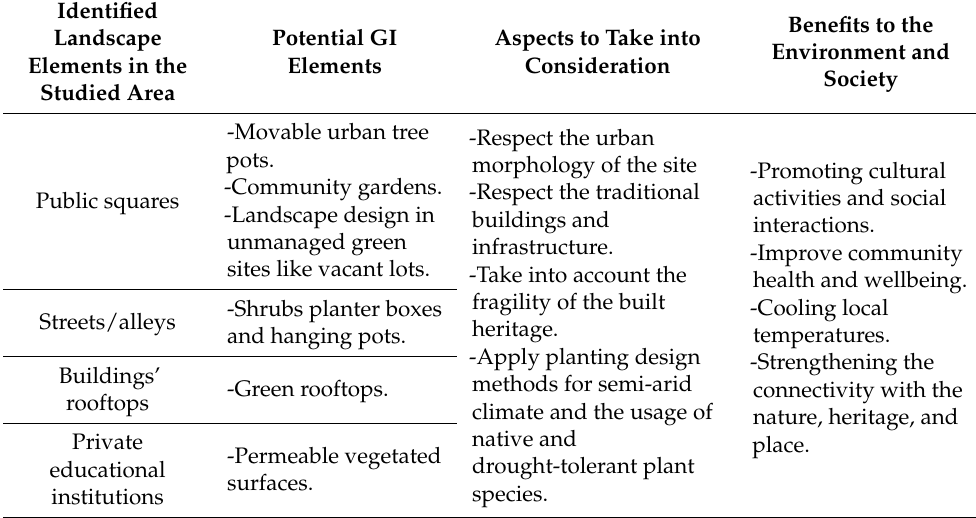
Table 1. Design proposals in the study area.